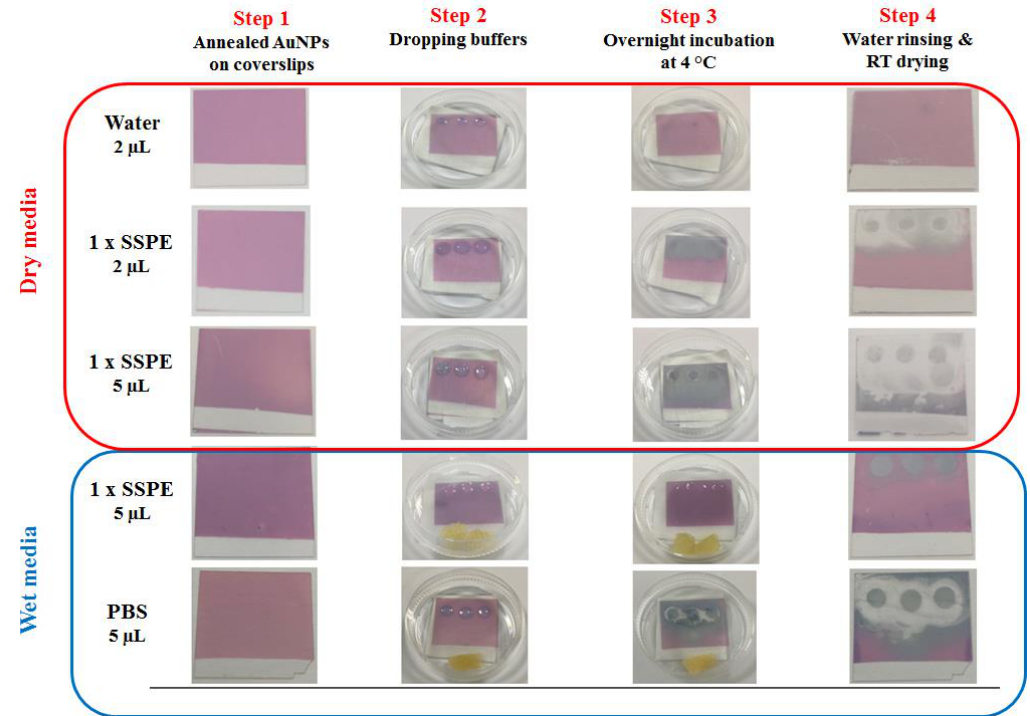
Figure 2. Naked-eye coverslips coated with annealed gold nanoparticles and exposed to wet and dry media for an overnight at 4 °C.